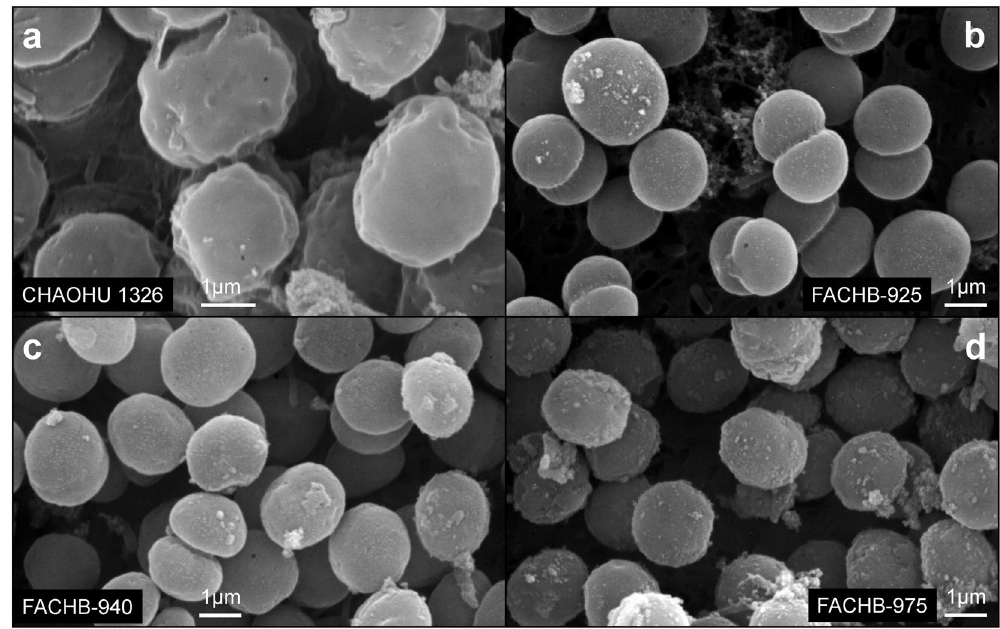
Figure 3. SEM images of the four M. aeruginosa strains grown to mid-exponential phase in BG11 medium, including M. aeruginosa CHAOHU 1326 ( a ), M. aeruginosa FACHB-925 ( b ), M. aeruginosa FACHB-940 ( c ), and M. aeruginosa FACHB-975 ( d